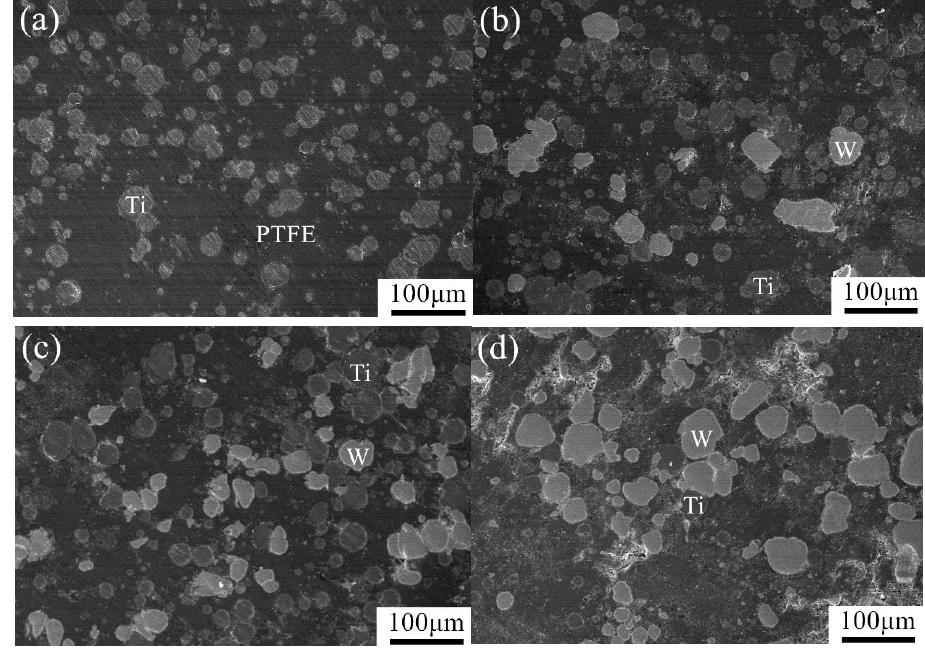
Figure 3. Backscattered scanning electron microscope (SEM) images of PTFE/Ti/W composites: ( a ) 68PTFE/32Ti; ( b ) 47PTFE/23Ti/30W; ( c ) 34PTFE/16Ti/50W; ( d ) 20PTFE/10Ti/70W.